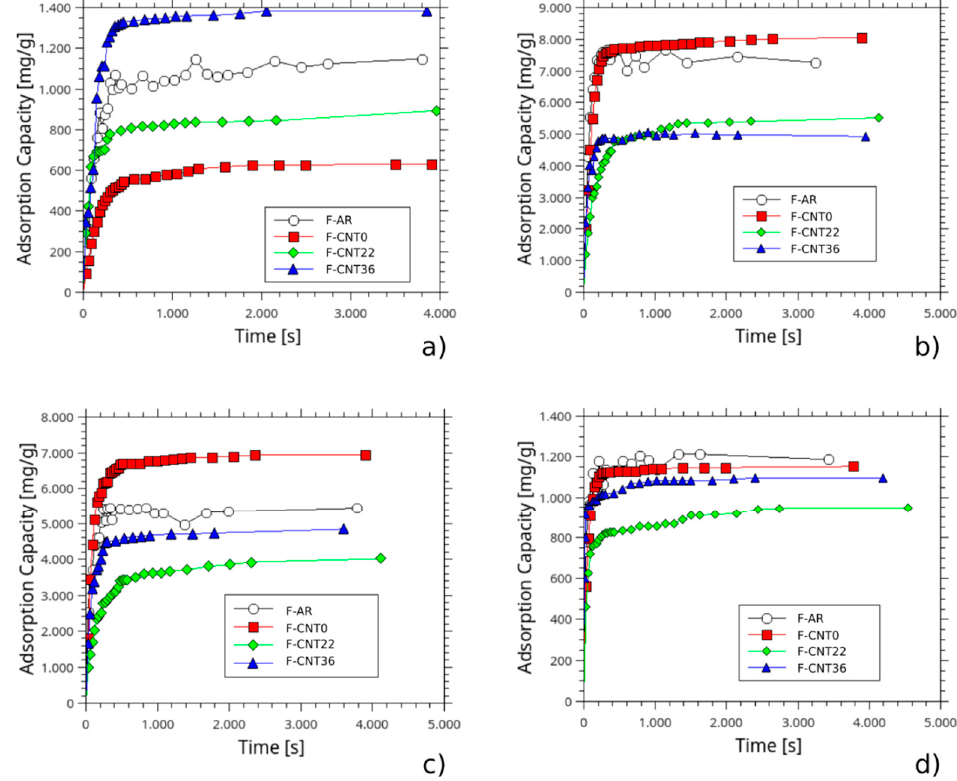
Figure8. Sorptioncapacityatincreasingsorptiontimeforallfoamsin( a )water, ( b )naphtha, ( c )kerosene, Figure 8. Sorption capacity at increasing sorption time for all foams in ( a ) water, ( b ) naphtha, ( c ) ( d ) pump kerosene, ( d ) pump oil.